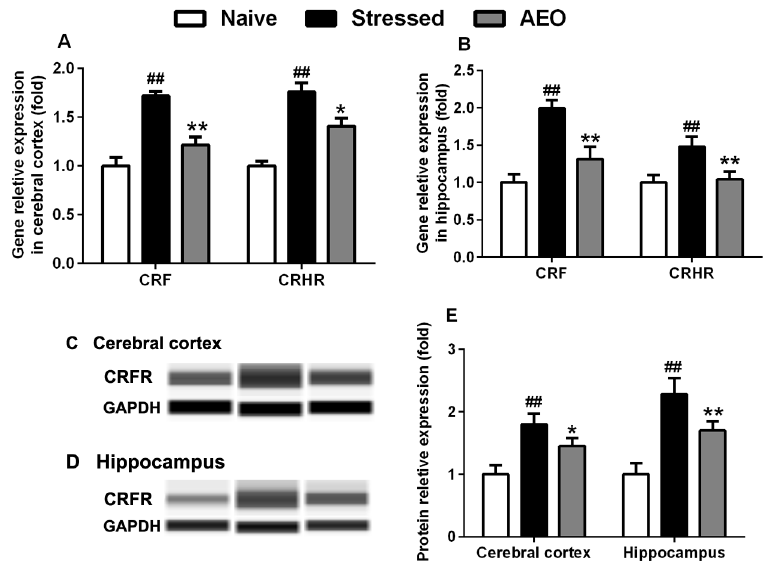
Figure 8. Effects of AEO on the expression of corticotropin releasing factor (CRF) and CRF receptor (CRFR). CRF and CRFR gene transcription were assessed by RT-PCR in ( A ) cerebral cortex and ( B ) hippocampus, and CRFR protein expression was detected by Wes in the ( C ) cerebral cortex and ( D ) hippocampus of mice. ( E ) The quantitative result of relative expression was showed in fold. Each value represents mean ± SEM, n = 3 with three independent biological replicates. ## p < 0.01 vs. the naive group, * p < 0.05 and ** p < 0.01 vs. the stressed group.